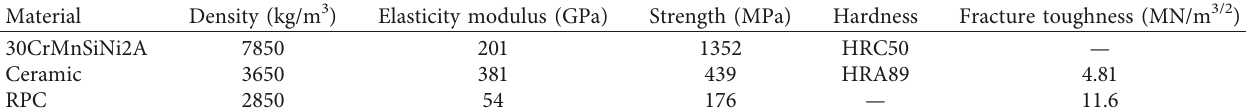
Table 1: Material parameters of ceramic and